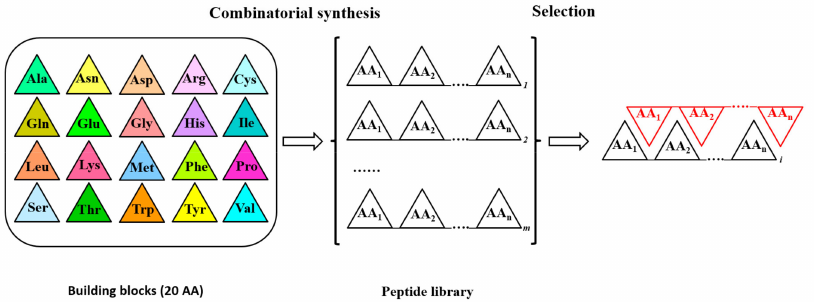
Figure 3. Synthesis and screening of a combinatorial peptide library. The synthesis of an n-mer peptide combinatorial library is schematized. Coloured triangles stand for specific amino acids (AA) used for a randomized synthesis of n-mer peptides. White triangles represent any possible amino acid in synthesized peptides. n = peptide length; m = total number of peptides in the library (m = 20 n ). Amino acids in red triangles constitute a specific peptide used as a bait for the selection from the library of the peptide with the highest a ffi nity (the length of the bait is not necessarily “n” amino acids). In general, any kind of molecule able to interact with peptides can be used as a bait. The library or the bait are fixed on a solid support to allow selection. In the first case the positions of each peptide on the solid support is known. In DNA based combinatorial libraries, a selected number of codons is randomized in order to obtain after expression the corresponding combinatorial peptide library. In phage display libraries, for example, the gene of interest (containing the chosen degenerated codons) is fused with the gene for a phage surface protein. In this way, after expression of phage particles in Escherichia coli cells, a combinatorial phage library is produced and can be used in the selection